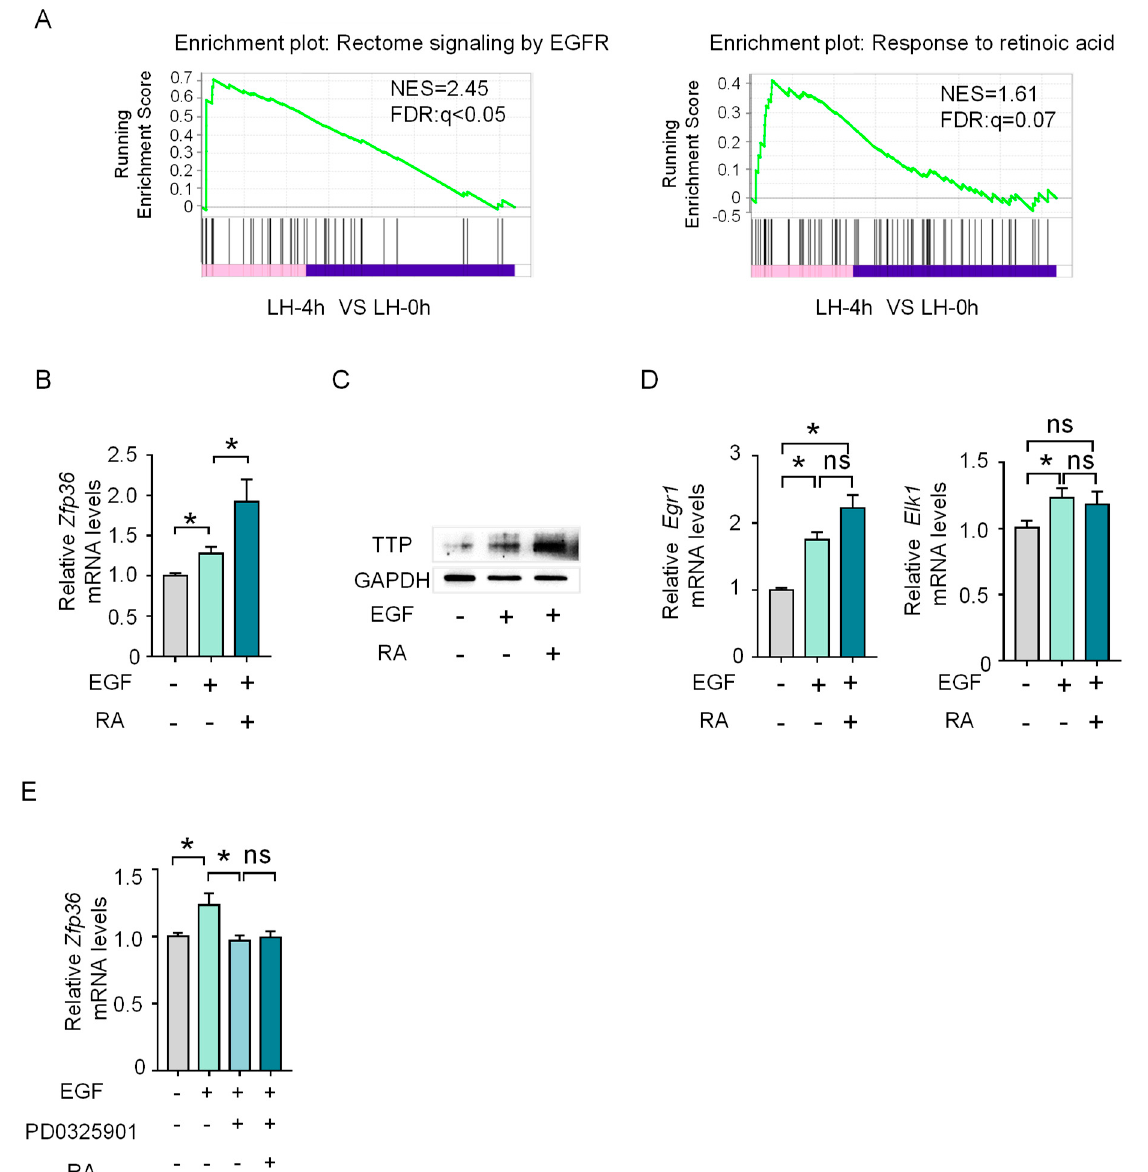
Figure 6. RA signaling cooperates with parallel EGF signaling to upregulate Zfp36 through the ERK-dependent pathway. ( A ) GSEA analysis showing enrichment of Rectome signaling by EGFR and Response to retinoic acid, Normalized enrichment score (NES) and false discovery rate (FDR) q value are shown. ( B ) The mRNA expression levels of Zfp36 in MGCs cultured with EGF alone or together with RA. * p < 0.05 ( C ) The Western blotting analysis of TTP in MGCs cultured with EGF alone or together with RA. * p < 0.05 ( D ) The mRNA expression levels of Egr1 and Elk1 in MGCs cultured with EGF alone or together with RA. * p < 0.05, ns, not significant ( p > 0.05). ( E ) The mRNA expression levels of Zfp36 in MGCs cultured with EGF alone or various combinations with RA and PD0325901. * p < 0.05, ns, not significant ( p > 0.05).